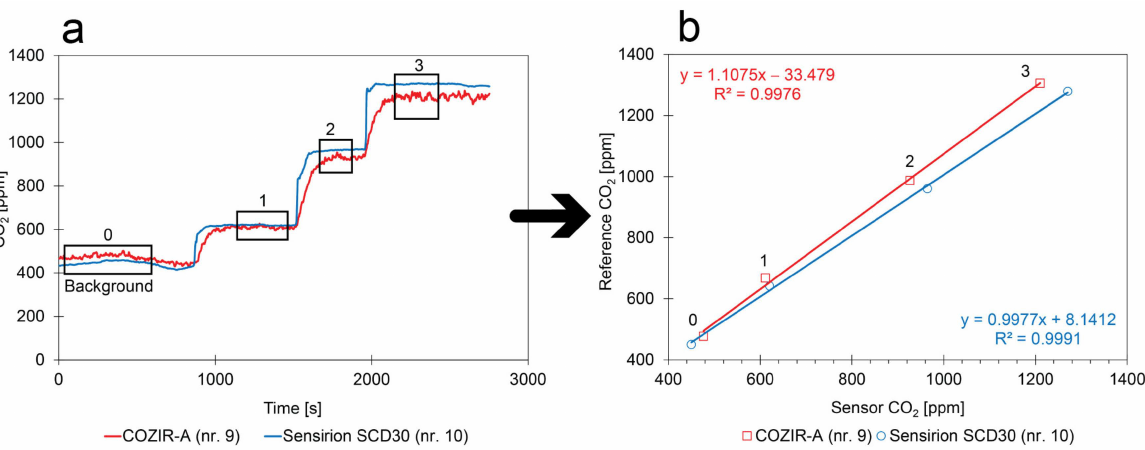
Figure 13. ( a ) Concentration trends of CO 2 when calibration gas is introduced on top of the back- ground concentration performed in Cuba; ( b ) calibration curve obtained by the standard addi- tion